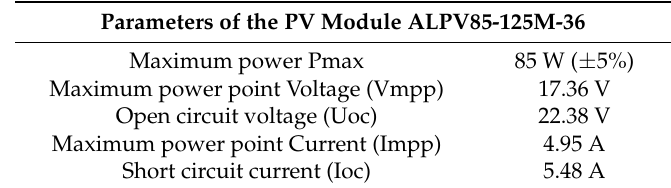
Table 1. The main parameters of the proposed PV module.